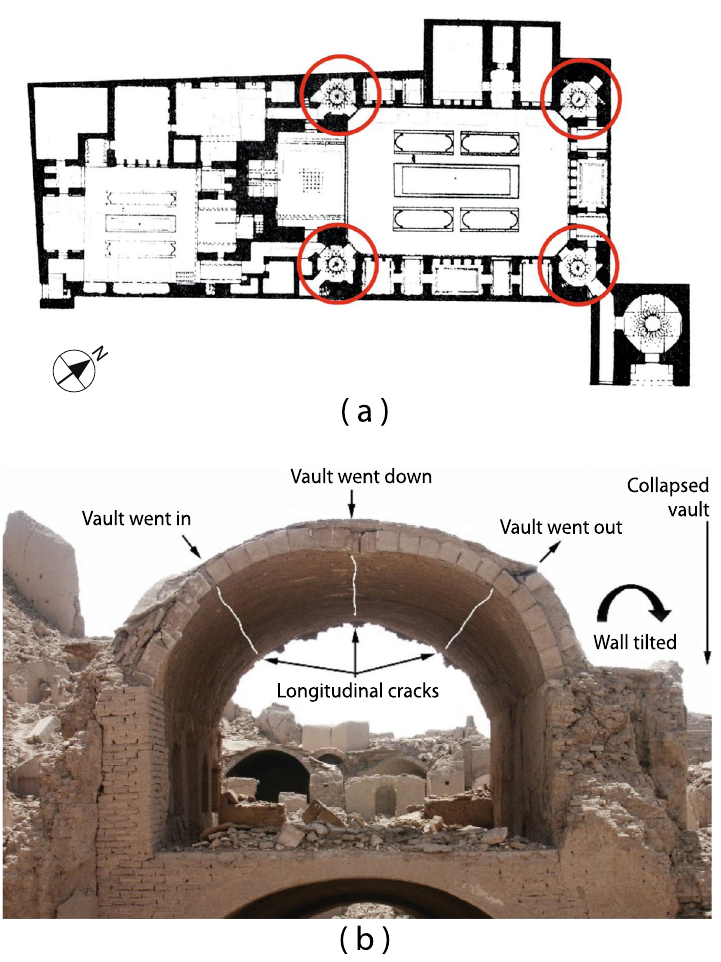
Fig. 23 Collaborative action of neighbouring constructions: ( a ) the layout of curved roofs in the Mortaz house, Yazd (domes marked by red circles) (Source: Haji‑Qassemi and Khoei 2004) and ( b ) a vault that lacked collaborative action and was damaged in the Bam earthquake (Source: Maïni and